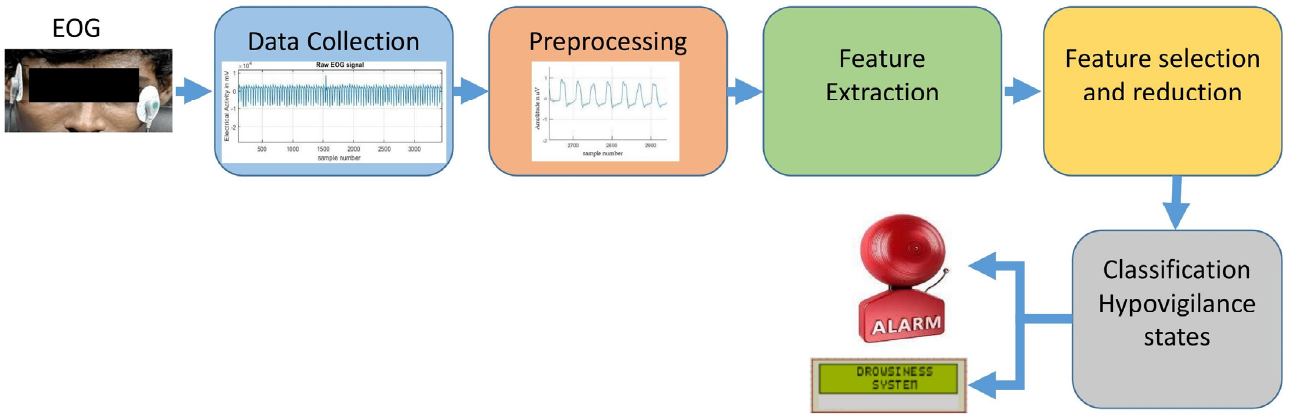
Figure 1 . Hypovigilance detection system methodology. Figure 1. Hypovigilance detection system